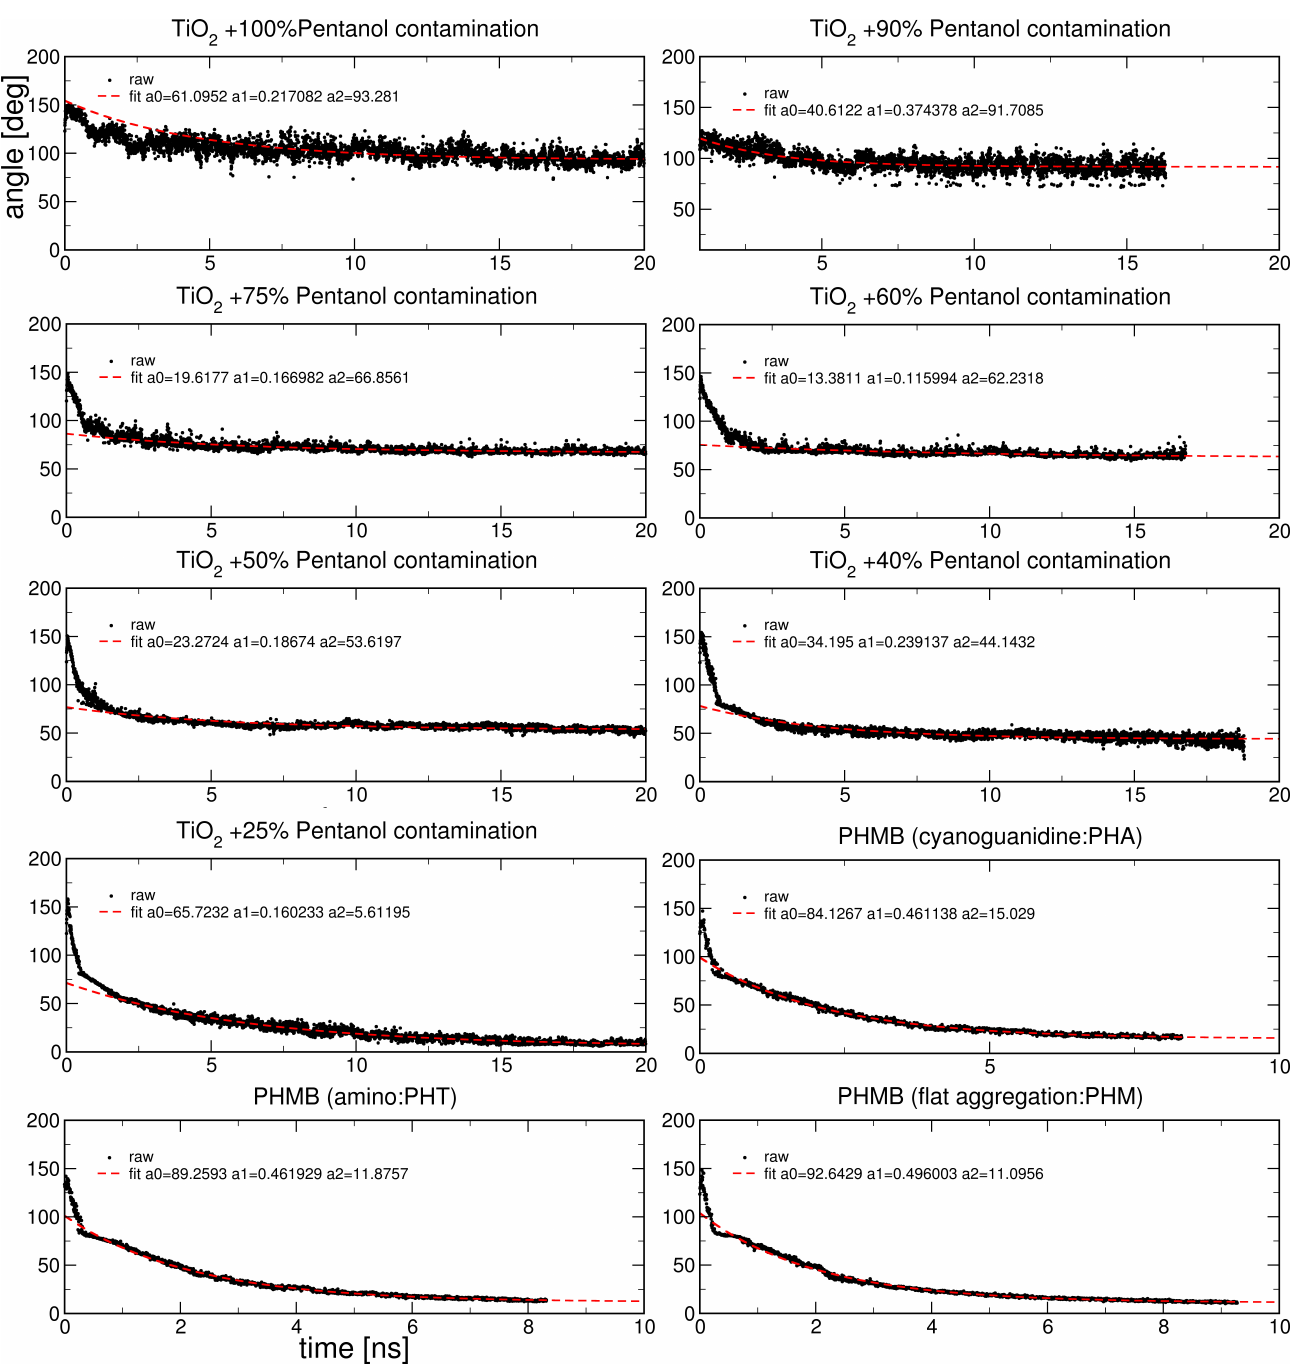
Figure A1. Raw WCA data obtained by novel automated 3D ellipsoid fit procedure and subsequent decay fit.